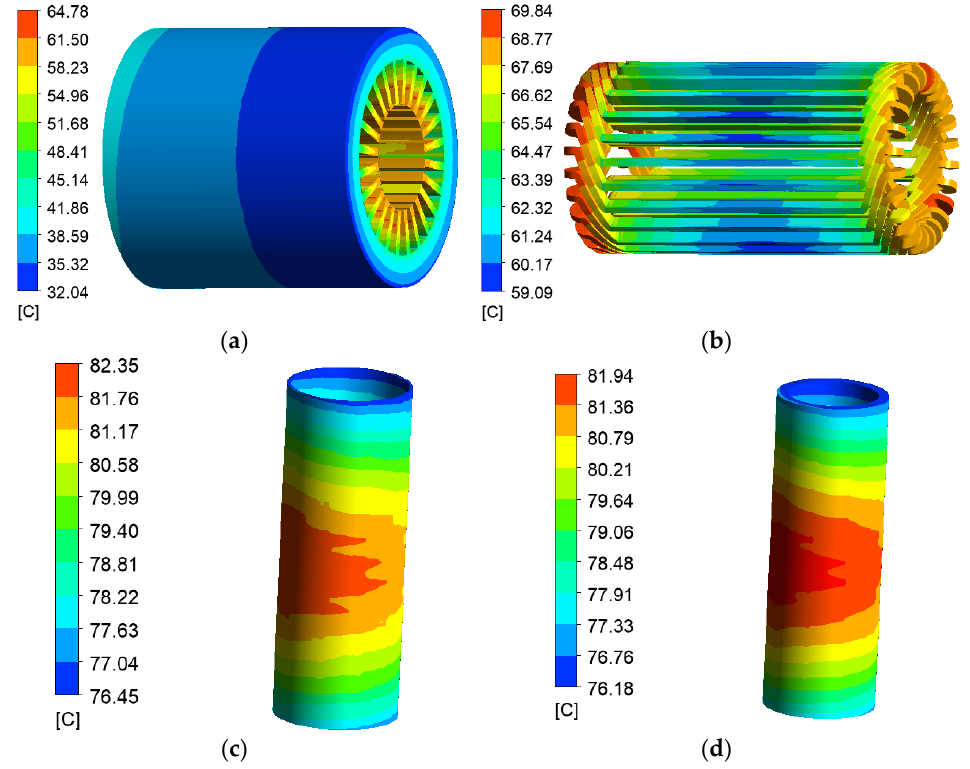
Figure 17. Temperature distribution of the designed motor. ( a ) Stator; ( b ) winding; ( c ) sleeve; ( d ) PM.